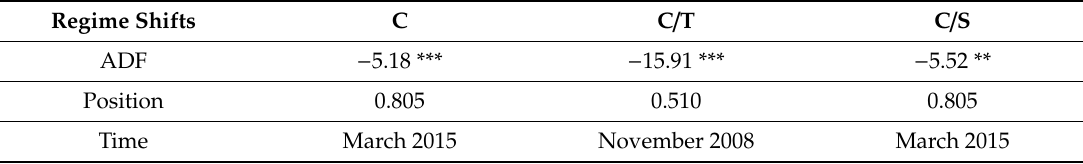
Table 6. Gregory–Hansen cointegration test results.